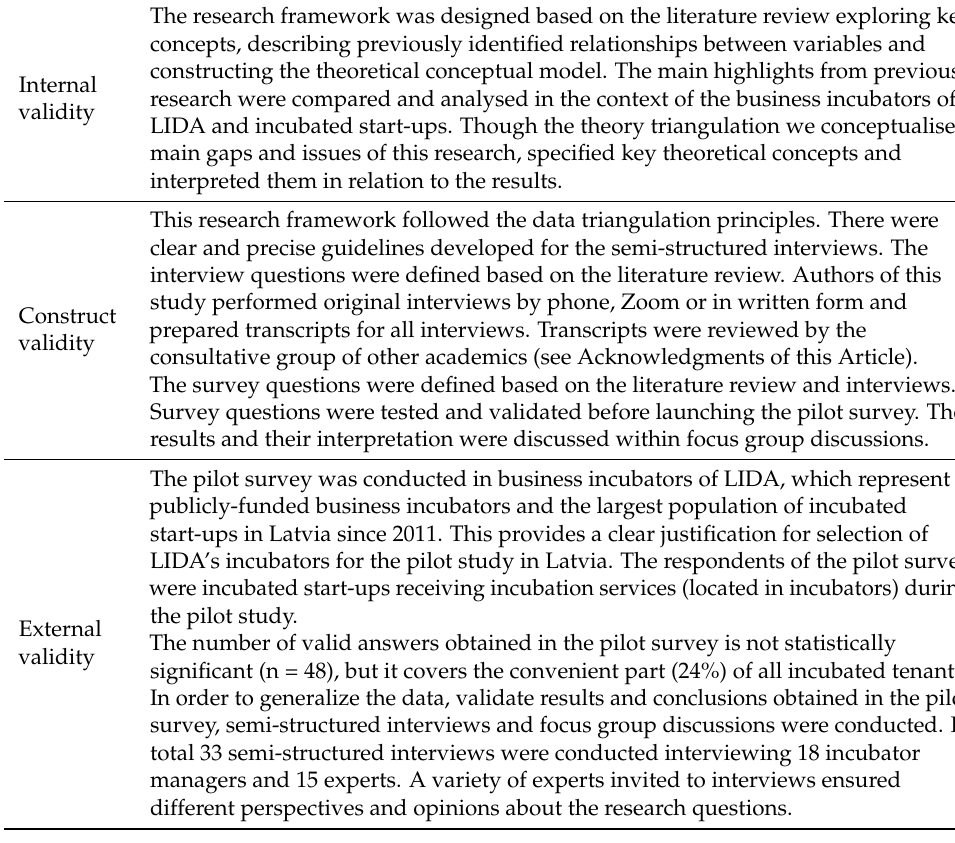
Table 1. The internal validity, the construct validity, the external validity and the reliability of this research (source: the